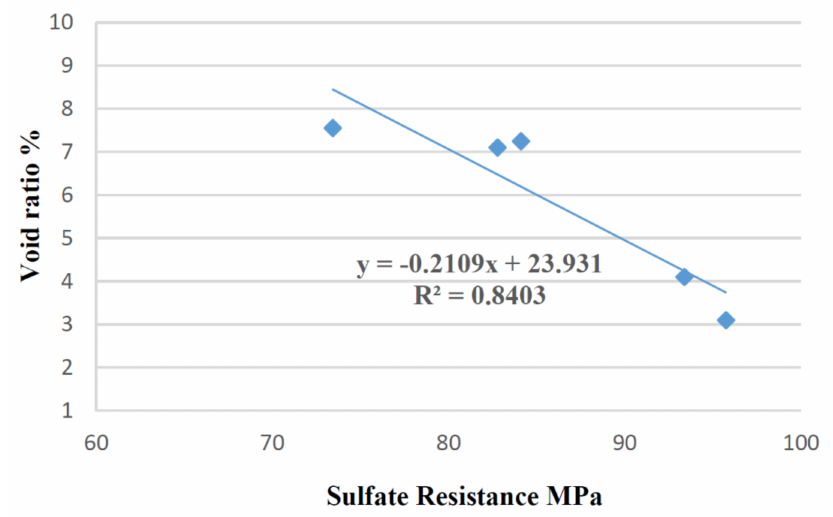
Figure 12. Correlation between voids ratio and sulfate attack